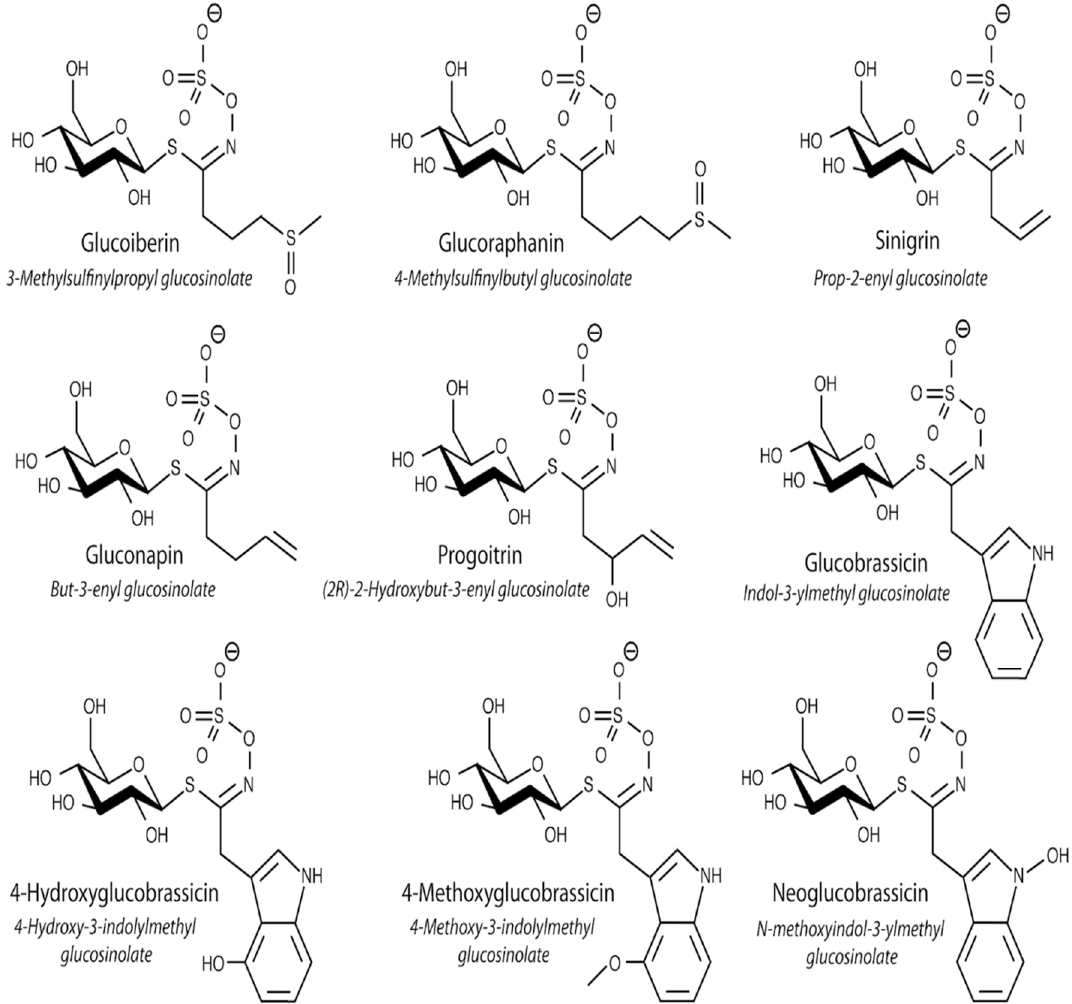
Figure 1. The structures of glucosinolates detected in young shoots of white and red cabbage. In total glucosinolates content of young shoots of both red- and white headed cabbage, the share of aliphatic glucosinolates was highest and was 23.42 and 24.96 µ mol/1 g d.m., respectively. Then were indolic ones (2.81 and 2.98 µ mol/1 g d.m., respectively). There were no aryl glucosinolates. Young shoots of red headed cabbage contained significantly more ( p ≤ 0.05) aliphatic glucosinolates than those of white headed cabbage. The content of indole glucosinolates was similar in both species of young shoots ( p >